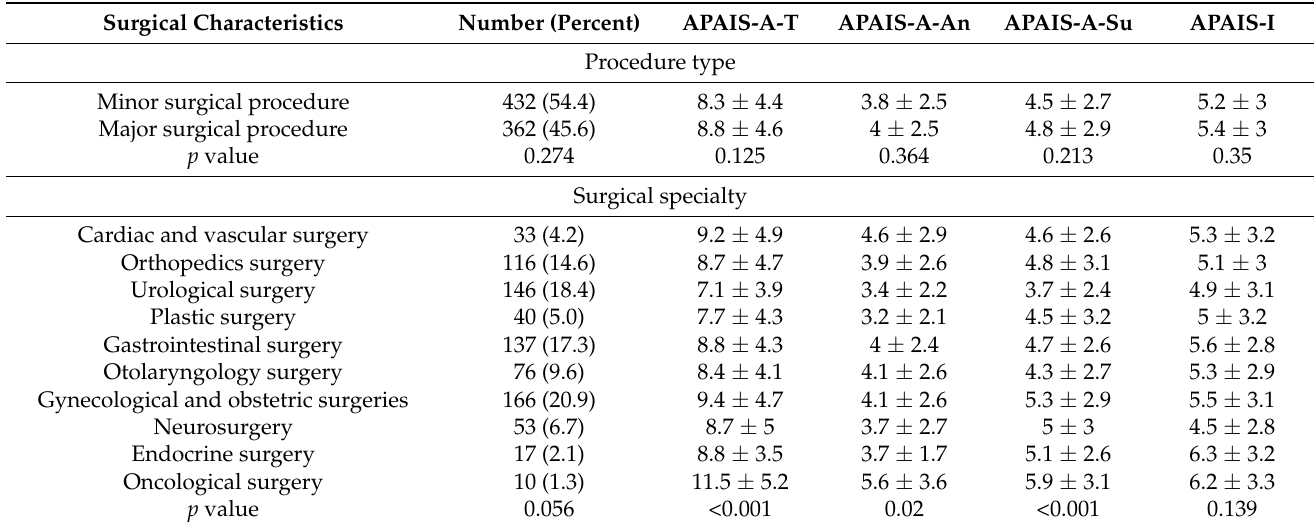
Table 2. A comparison between different surgical specialties in Amsterdam preoperative anxiety and information scale about anesthesia and